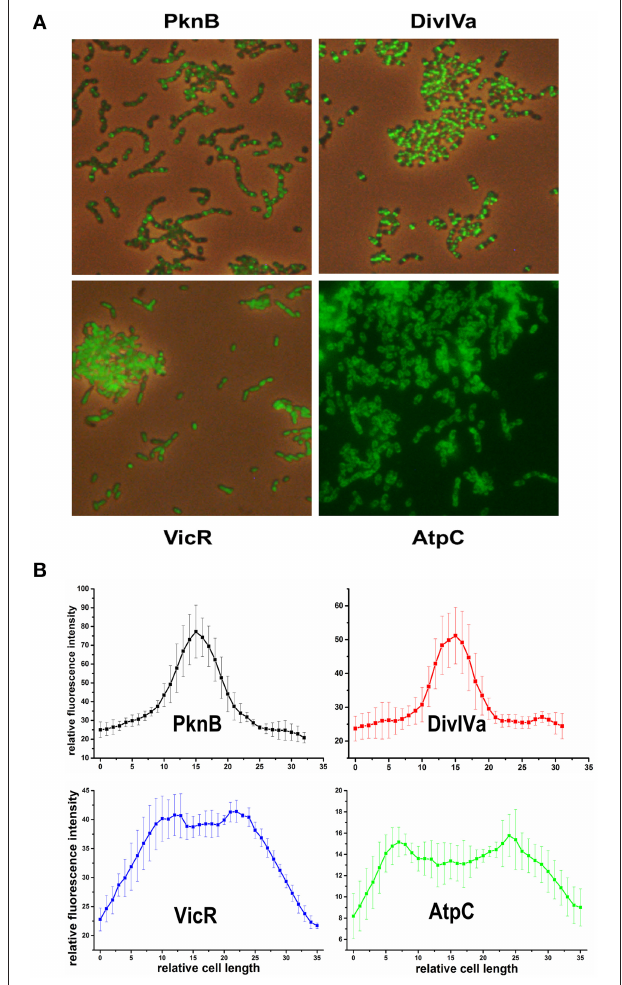
FIGURE 1 | Localization of PknB-, DivIVa-, VicR-, and AtpC-GFP + fusion proteins in S. mutans UA159. Expression of the different N-terminally tagged GFP + -fusion proteins in strains MR35-38 is under control of the promoter of the S. mutans glucosyltransferase B ( gtfB ). Strains were grown to exponential growth phase (OD 600 = 0.5) in THBY medium. (A) shows overlay images (GFP fluorescence and phase contrast) derived from the PknB, DivIVa, and VicR reporters. Due to the low contrast of the overlay image of strain MR38 a fluorescence image of strain MR38 is depicted. (B) shows the fluorescence intensity along the main cell axis of 5 randomly chosen cells. It was determined using the image J software.